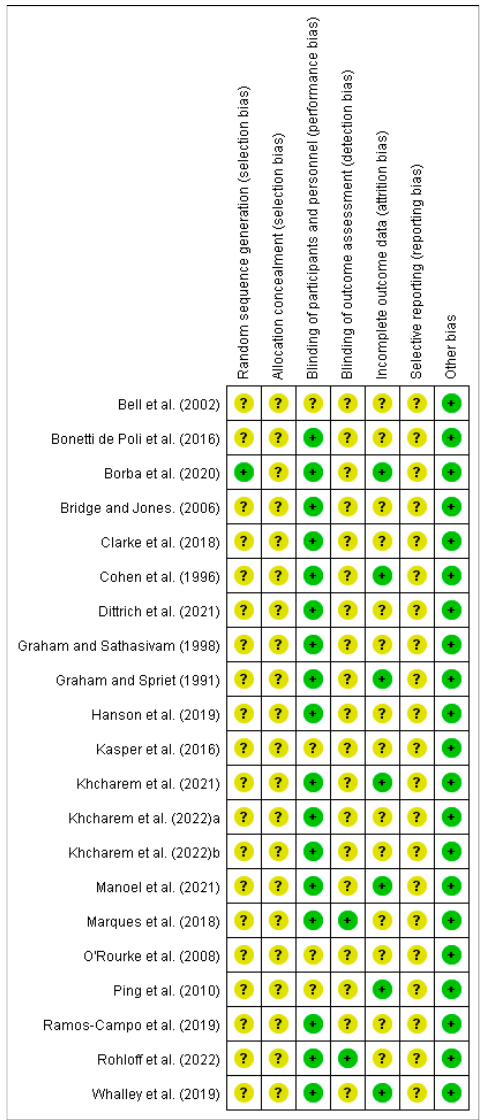
Figure 2. Risk of bias summary: determination of the risk of bias items for included studies. (+) = low risk of bias; (?) = unclear risk of bias. A total of 21 papers [7,23–26,30,34,35,42–54] were